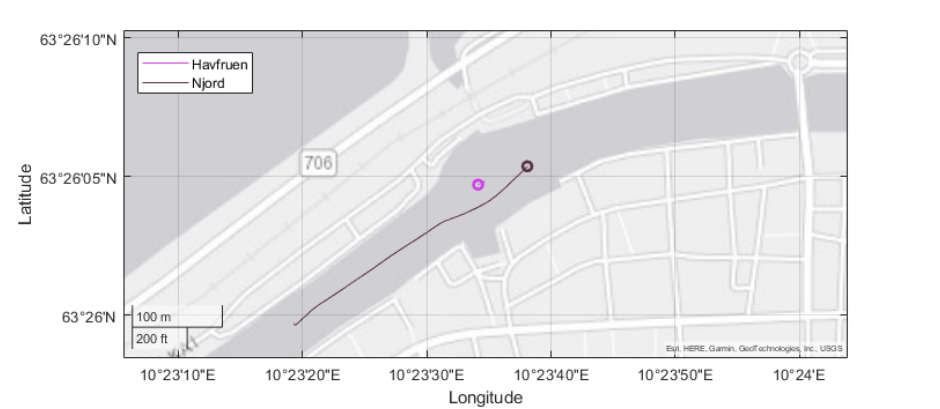
Figure 16. Test scenario 5. The circle depicts the end position.